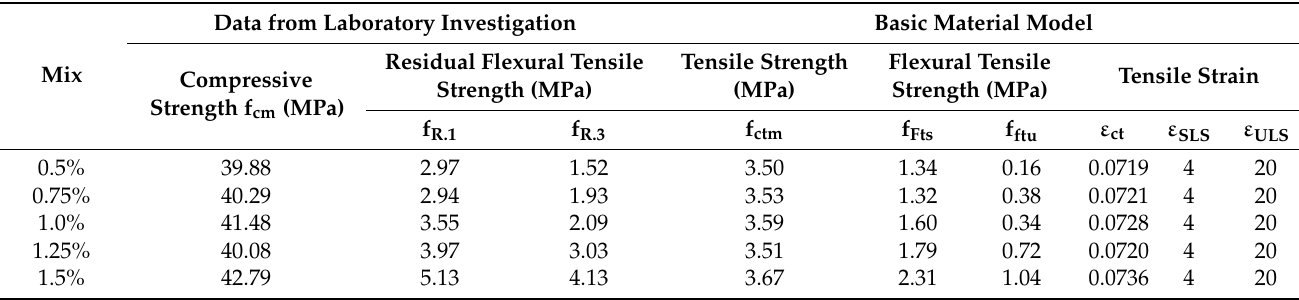
Table 5. The parameters of the basic material model [20] with the data from the laboratory